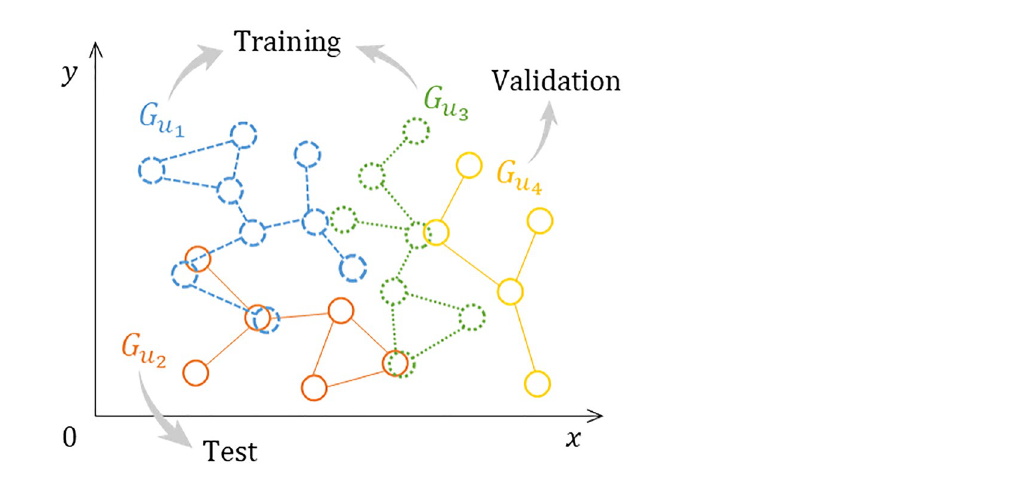
Figure 3. Random split of activity zone graphs into training, validation, and test sets based on the individuals they belong to.